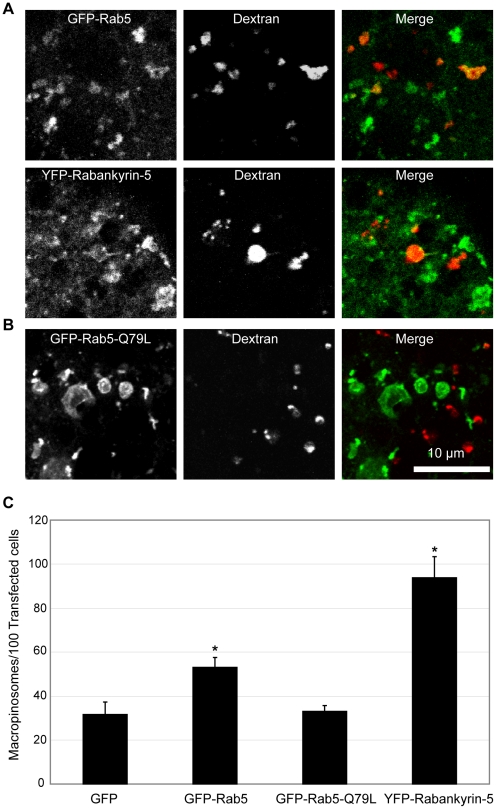
Rab5 and Rabankyrin5 overexpression increases macropinosome formation.The distribution of Rab5, Rabankyrin-5 (A) or Rab5(Q79L) (B) in green relative to dextran-positive macropinosomes (red) Scale bar  = 10 µm. (C) HEK-Flp-In cells were transiently transfected with pEGFP-C1, pEGFP-Rab5, pEGFP-Rab5-Q79L and pEYFP-Rabankyrin-5. The mean number of macropinosomes/100 transfected cells was quantitated over 3 replicates of 500 transfected cells for each condition. * denotes statistical significance (p<0.05) using the Student's T-test, performing pairwise analyses relative to cells transfected with pEGFP-C1 alone. Error bars denote S.E.M.